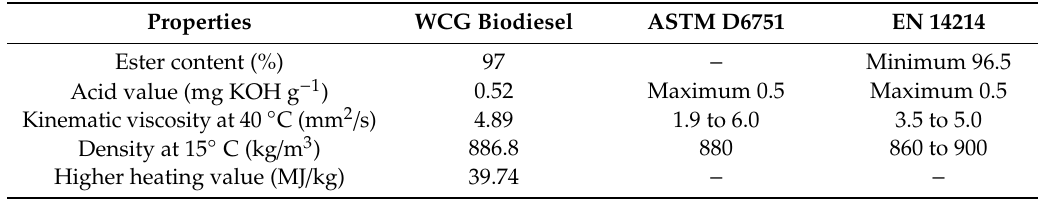
Table 8. Properties of WCG methyl